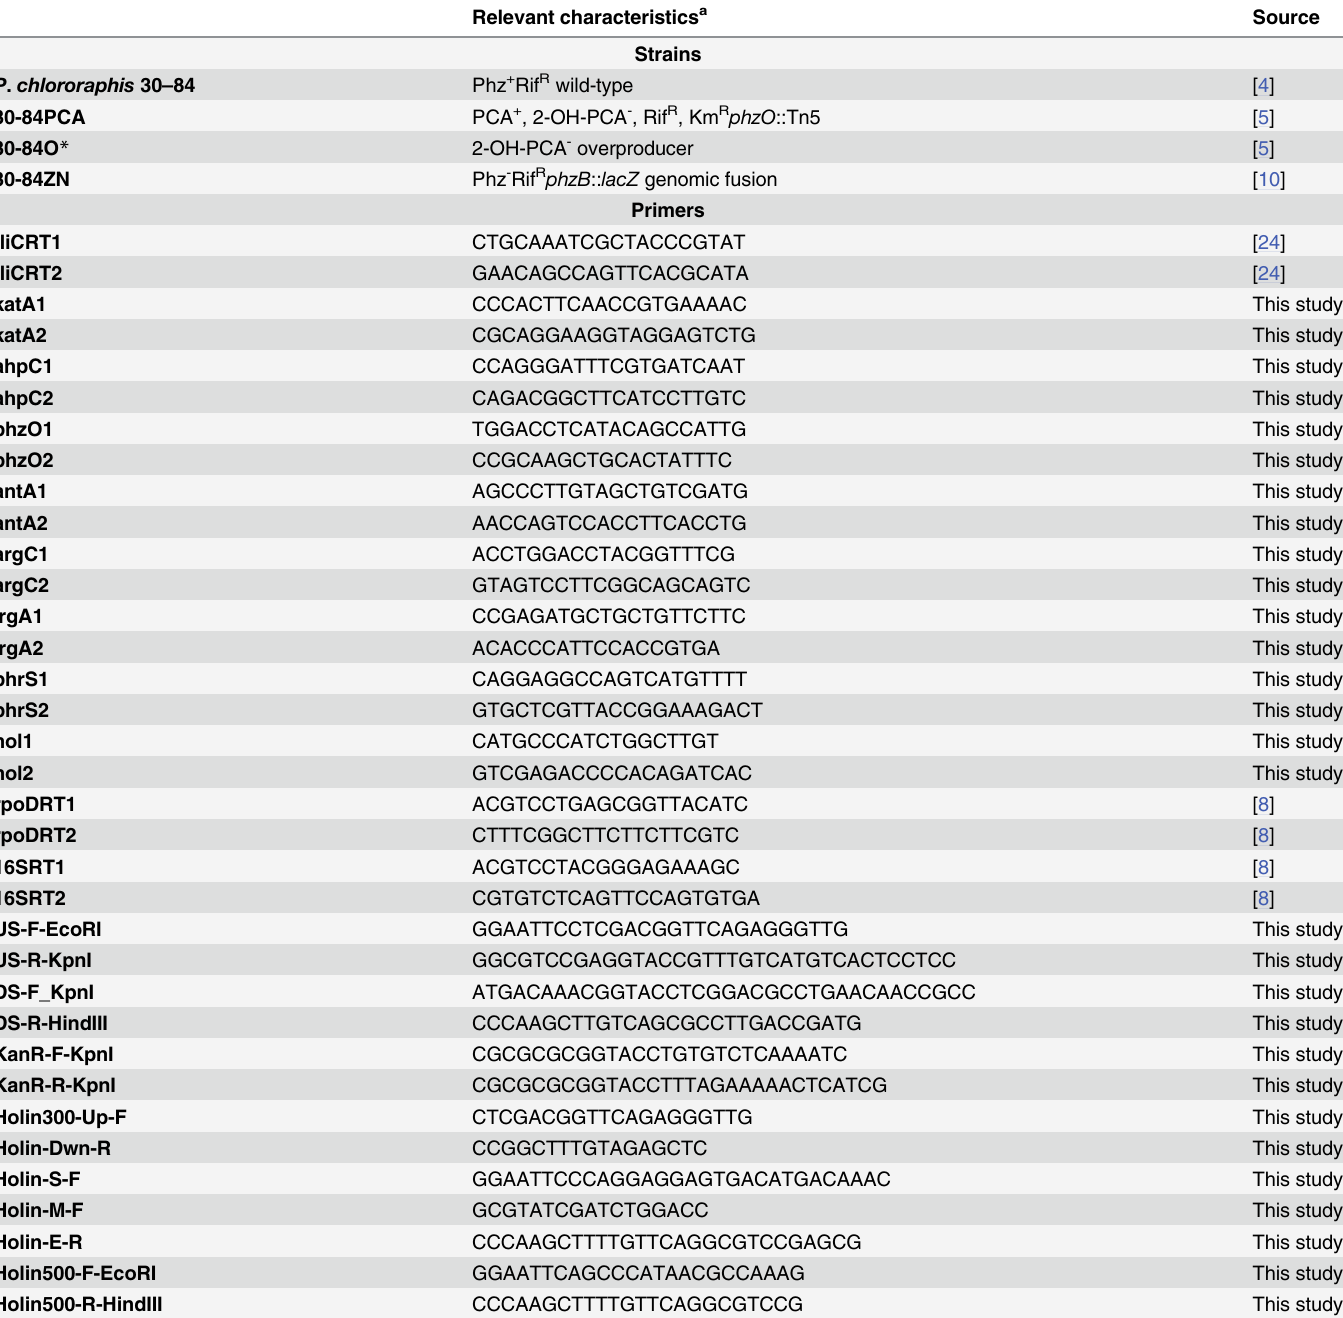
Table 1. Bacterial strains and primers used in this